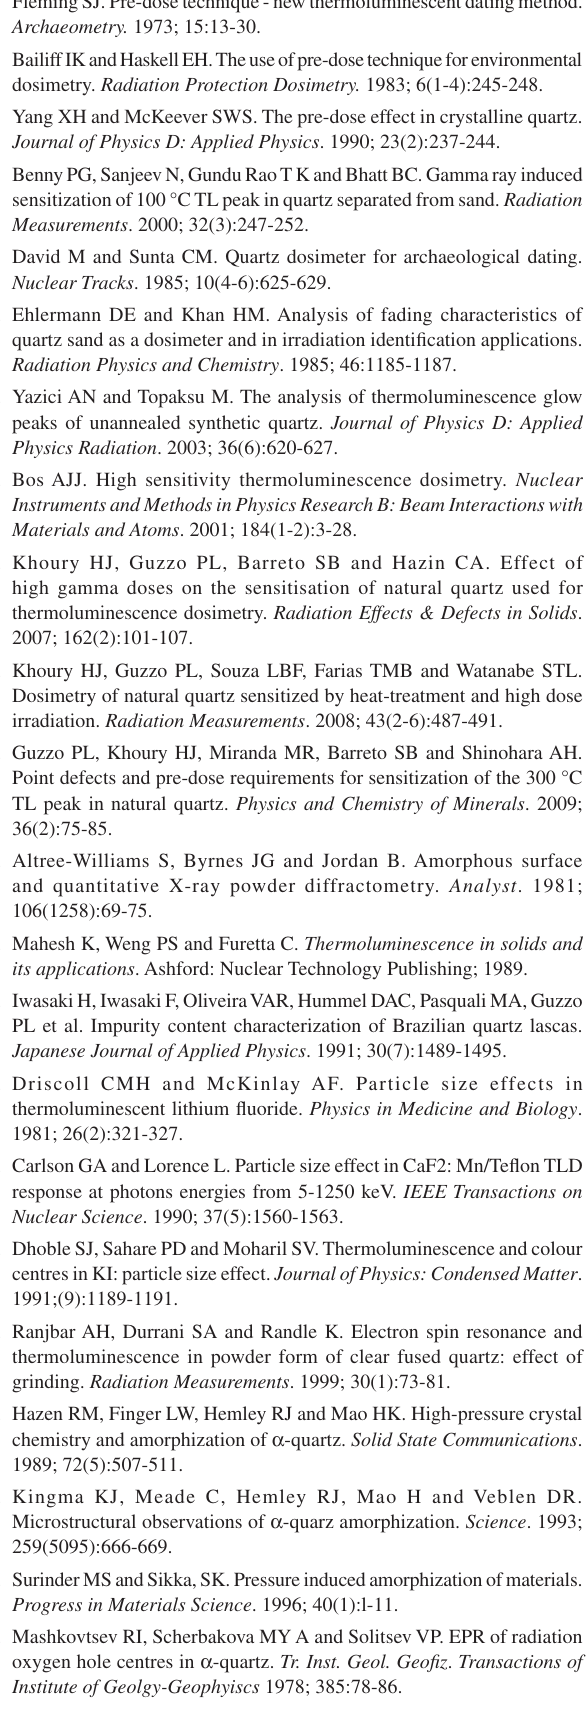
Figure 7. Relationship between the EPR intensity of E' substitutional Ge species and the mean particle size ( D